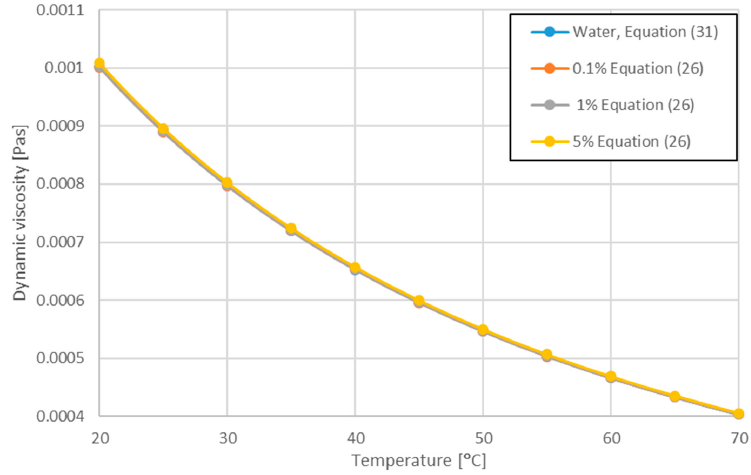
Figure 4. Viscosity of water-Al 2 O 3 nanofluids.